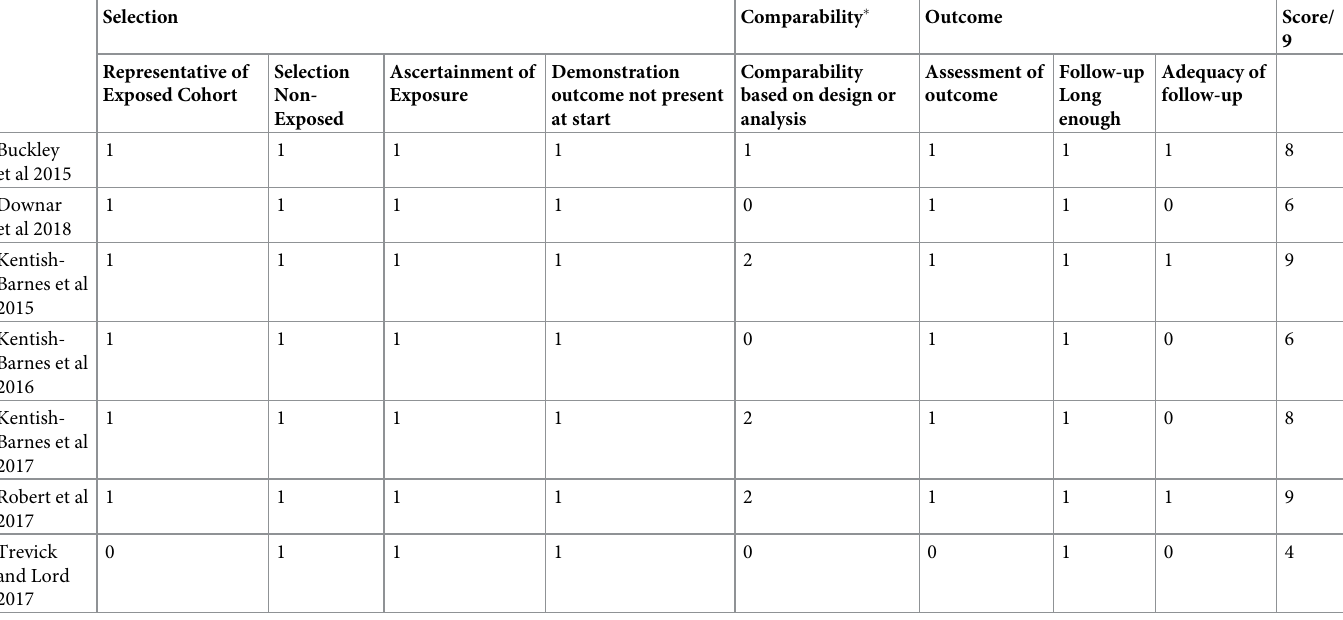
Table 4. Quality appraisal scores using the Newcastle Ottawa scale for included